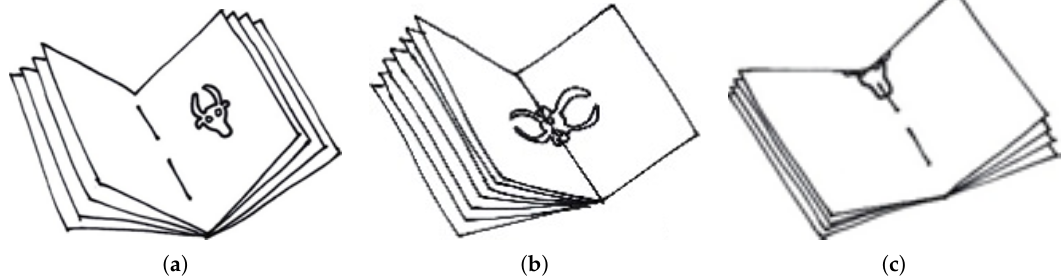
Figure 2. An example of positioning of a watermark on the page. It was common practice to produce big sheets of paper and fold them in order to achieve the desired page size. The amount of folds directly influences the possible locations of the watermarks on the final product. The location of the watermark with three different possible folds are shown in the diagram—one fold in ( a ), two folds in ( b ) and three folds in ( c